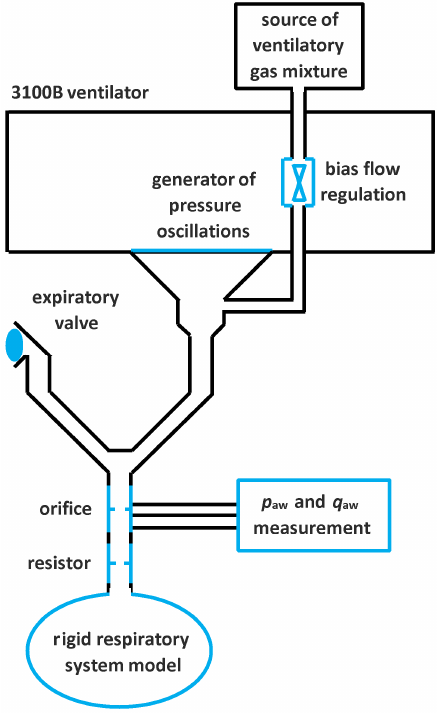
Figure 1. The arrangement of the experiment. The relative compliance X rs was calculated based on the power-spectral density S xx of the pressure and the cross-spectral density S yx of flow and pressure. The spectral densities were calculated from p aw and q aw using windows with a width of 2 s that moved along the signals with a step of 1 s. In the windows, the average value of a signal in the time domain was subtracted from the signal to remove the DC component in the frequency domain. Both spectral densities S xx and S yx were calculated using Welch’s averaged modified periodogram method of spectral estimation [39]. When calculating the spectral